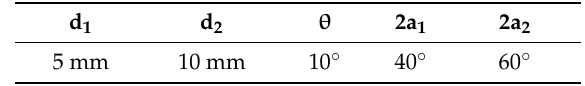
Figure 3. Bi-apex-angle liner used in the experiment. Table 1. Parameters of the BLSC liner.